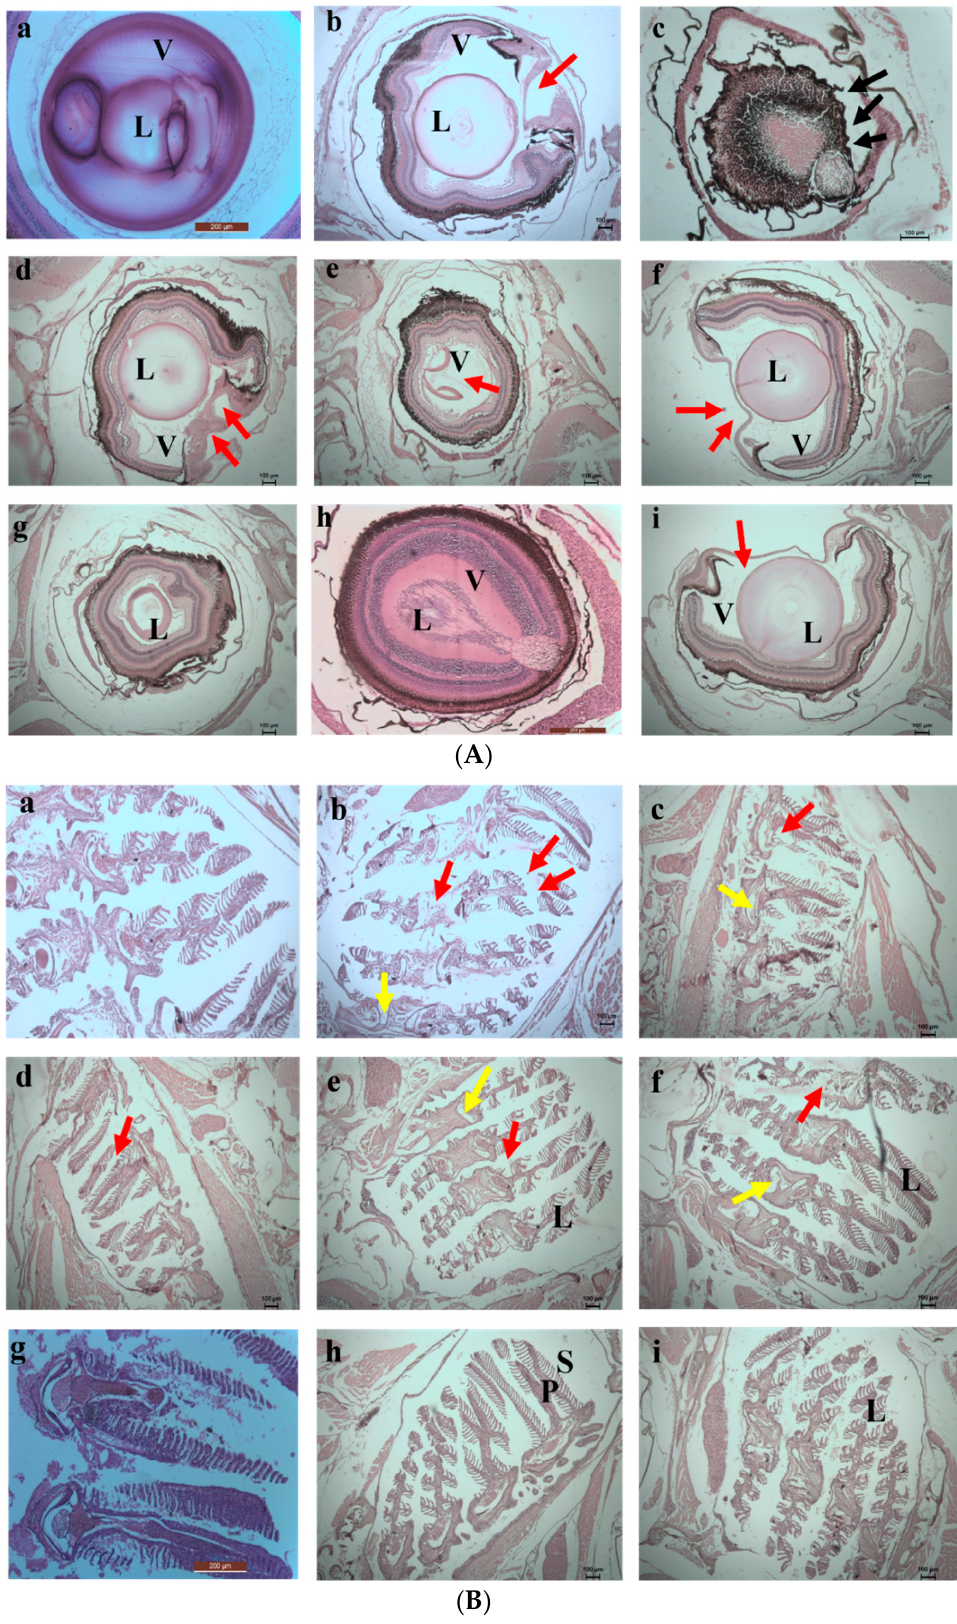
Figure 13. ( A ) 5th day. Histology images of eyes of zebrafish exposed to ( a ) Control ( b ) Test 1 — Chromium metal in water ( c ) Test 2 —SPIONs in water ( d ) Test 3 —Chromium metal with water in SPIONs ( e ) Test 4 —Chromium metal in water with SPIONs removed after interaction for 1 h ( f ) Test 5 —Chromium metal in water with alginate–SPIONs microspheres ( g ) Test 6 —Chromium metal in water with alginate–SPIONs microspheres removed after interaction for 1 h ( h ) Test 7 — Chromium metal in water with alginate beads ( i ) Test 8 —Chromium metal in water with alginate beads removed after interaction for 1 h. (Red arrow denotes erosion; L—lens, V—Vitreous). ( B ) 5th